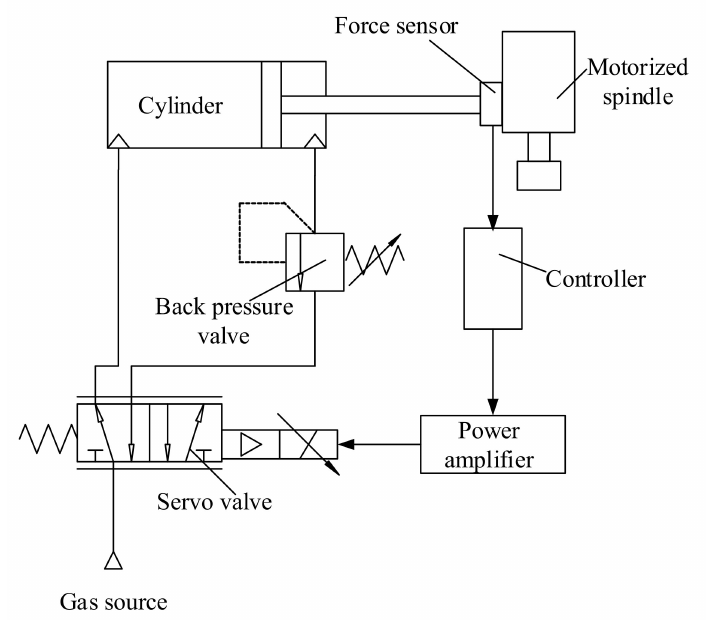
Figure 4. Schematic diagram of the pneumatic control based on the VER servo